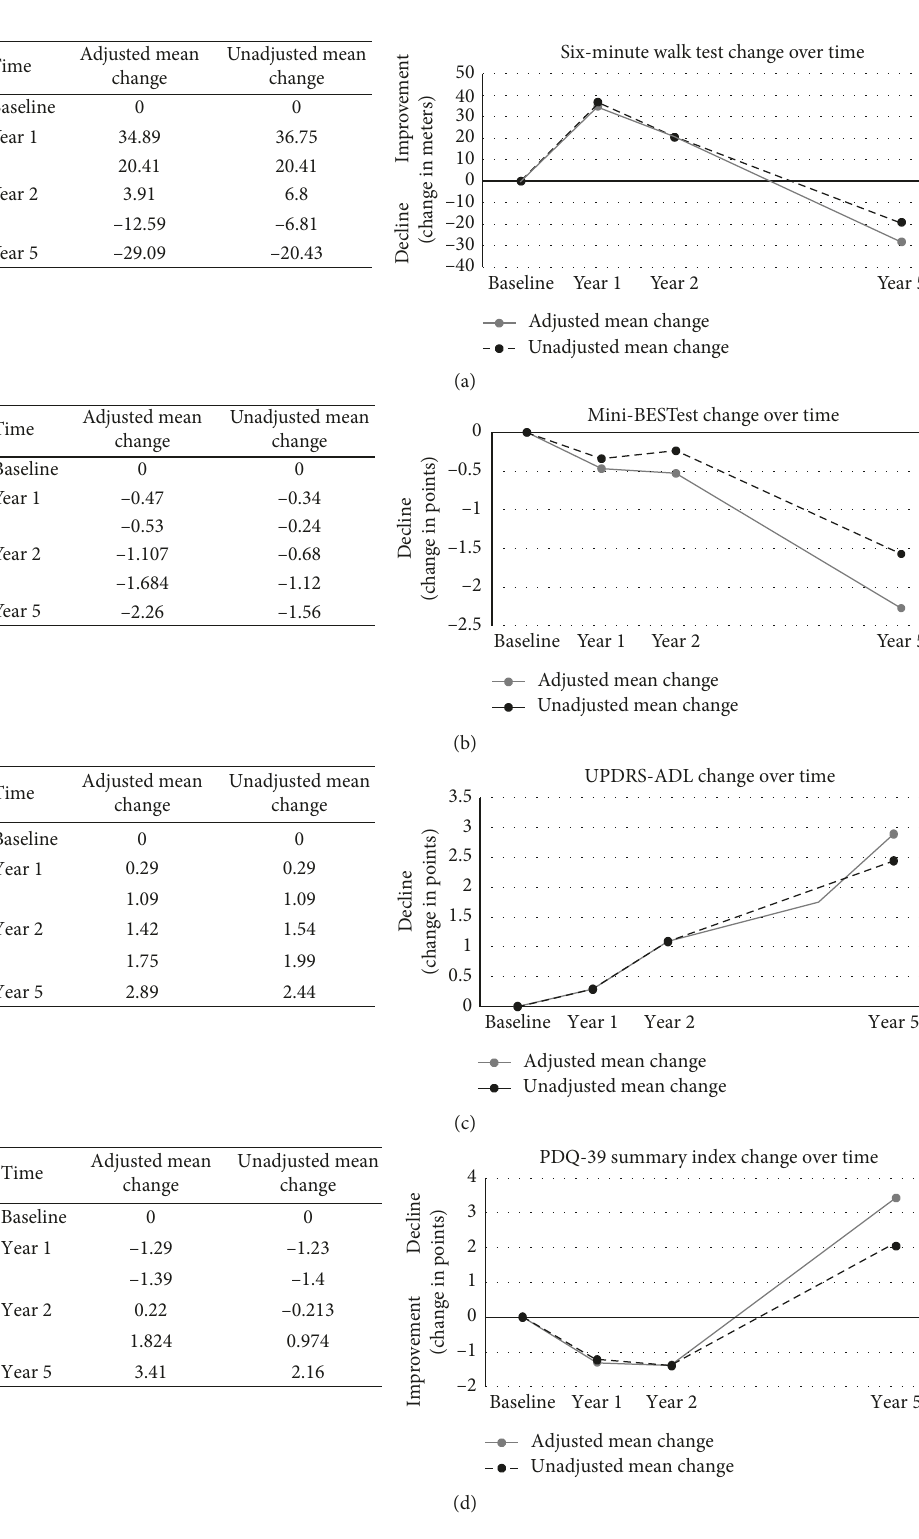
Figure 1: Change scores relative to baseline at years 1, 2, and 5. Grey line represents the adjusted change scores calculated from the LMM analysis (adjusted for age at PD diagnosis and PD subtype). Black dashed line represents the unadjusted, raw change scores. (a) Six-minute walk test change over time. (b) Mini-BESTest change over time. (c) UPDRS II (ADL subscale) change over time. (d) PDQ-39 summary index change over